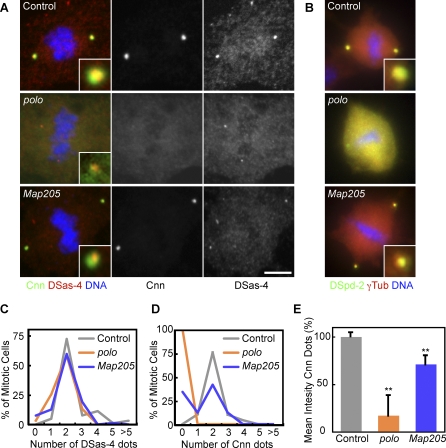
Genes Involved in PCM Recruitment (Class III)(A) S2R+ cells treated with dsRNA against GFP (control), polo, and Map205 were stained with Hoechst (DNA, blue), DSas-4 (a centriole marker, red), and Cnn (a PCM marker, green). Inset shows a 4× magnified view.(B) Recruitment of DSpd-2 (green) and γ-tubulin (red) after dsRNA treatment for control, polo, and Map205. DNA is shown in blue, and inset shows a 4× magnified view.(C and D) Analysis of centriole (C) and centrosome (D) numbers in mitotic cells after RNAi treatment. More than 30 mitotic cells were counted in two independent experiments.(E) Analysis of PCM size in mitotic cells after RNAi treatment. The graph represents the mean intensity of PCM staining (Cnn) from three independent experiments, each analysing more than 20 centrosomes. Error bars represent the SE; a single asterisk (*) or double asterisks (**) indicate p ≤ 0.05 or p ≤ 0.01 compared to control, respectively. Note how the number of centrioles per cell is not dramatically perturbed (C), but the number centrosomes (D) and the amount of PCM recruited to the centrioles (E) is reduced after polo and Map205 depletion.Scale bar (A and B) represents 5 μm.